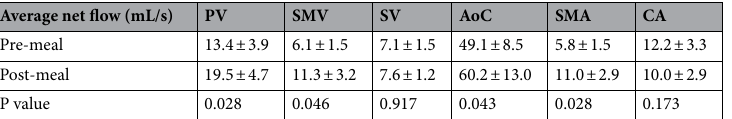
Average net flow